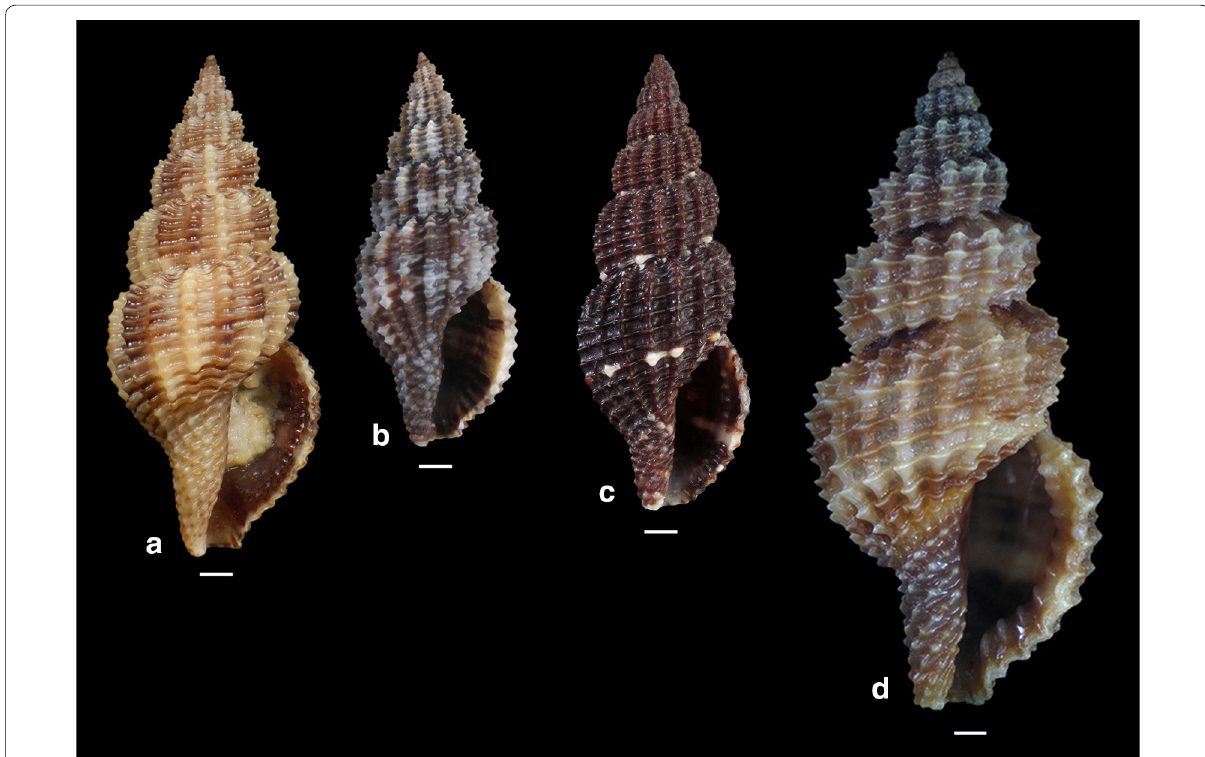
Fig. 24 a Raphitoma sophiae sp. n. holotype (15.55 mm), b Raphitoma densa (11.65 mm), c Raphitoma atropurpurea (13.50 mm), d Raphitoma echinata (sensu auctores ) Morphotype IV (20.95 mm). Bar